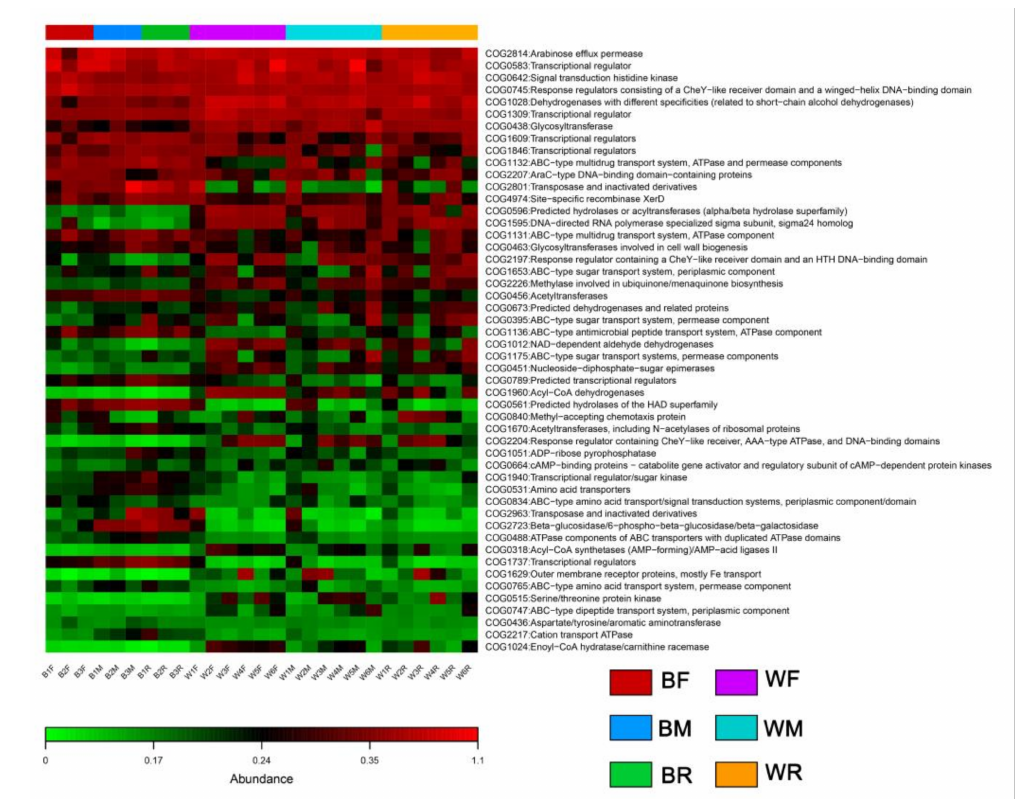
Figure 5. Differences in the functional profiles in pathways of the gut microbiota in cultivated and wild Mastacembelus armatus